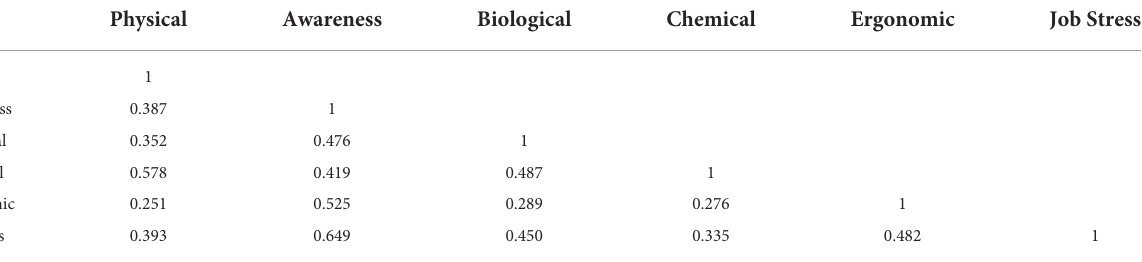
TABLE 1 Latent variable